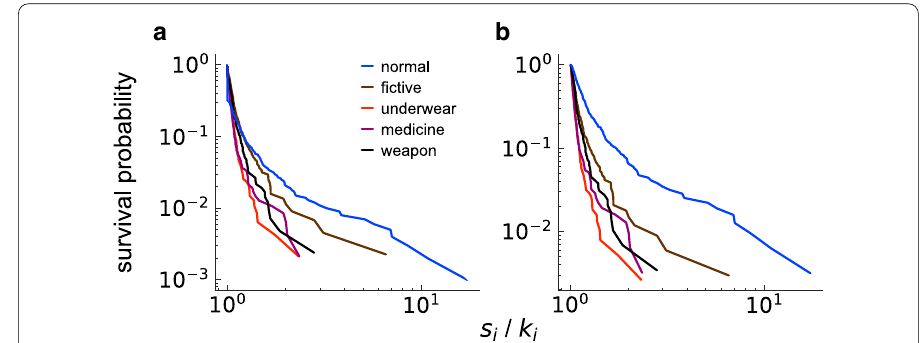
Fig. 4 Survival probability of the average number of transactions per neighbor. a s i / k i for all nodes. b s i / k i for the nodes with s i / k i > 1